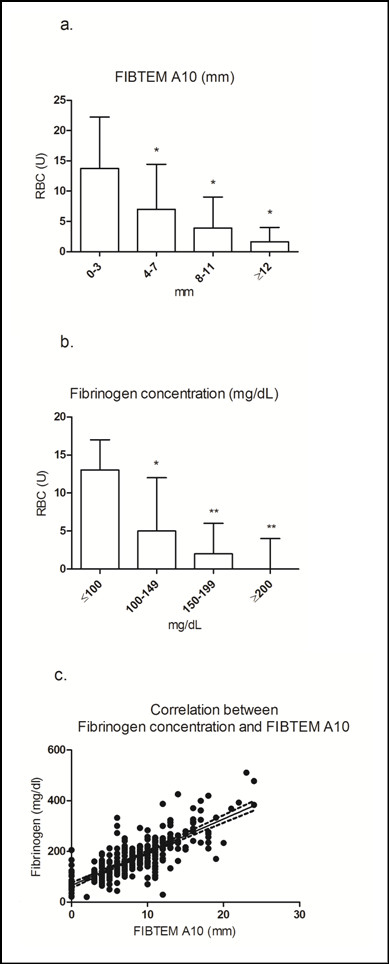
FIBTEM A10 and fibrinogen concentration on admission to the ER, and RBC transfusion. Low FIBTEM A10 (0 to 3 mm) and low fibrinogen concentration (<100 mg/dL) upon ER admission was associated with an increased requirement for RBC transfusion. A10, clot amplitude at 10 minutes after CT; ER, emergency room; FIBTEM, extrinsically activated thromboelastometric test with cytochalasin D; RBC, red blood cell concentrate. (a)* P < 0.0001 vs 0 to 3 mm; (b)* P < 0.001 vs ≤100 mg/dL; **P < 0.0001 vs ≤100 mg/dL; (c) Correlation between FIBTEM A10 and fibrinogen concentration rho = 0.75